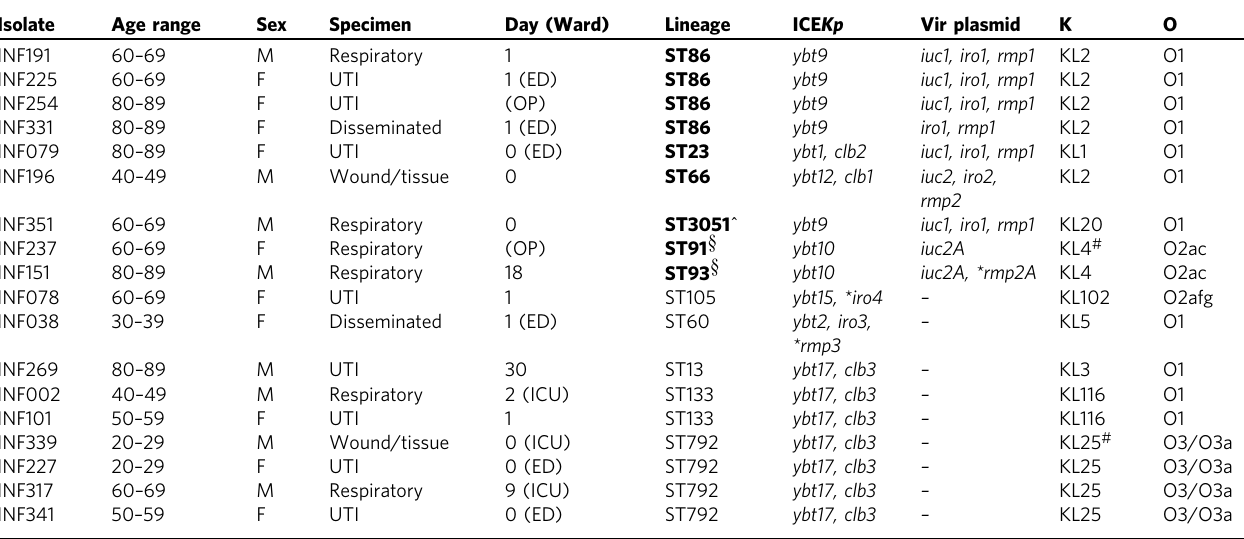
Table 4 Infections associated with carriage of acquired virulence factors.